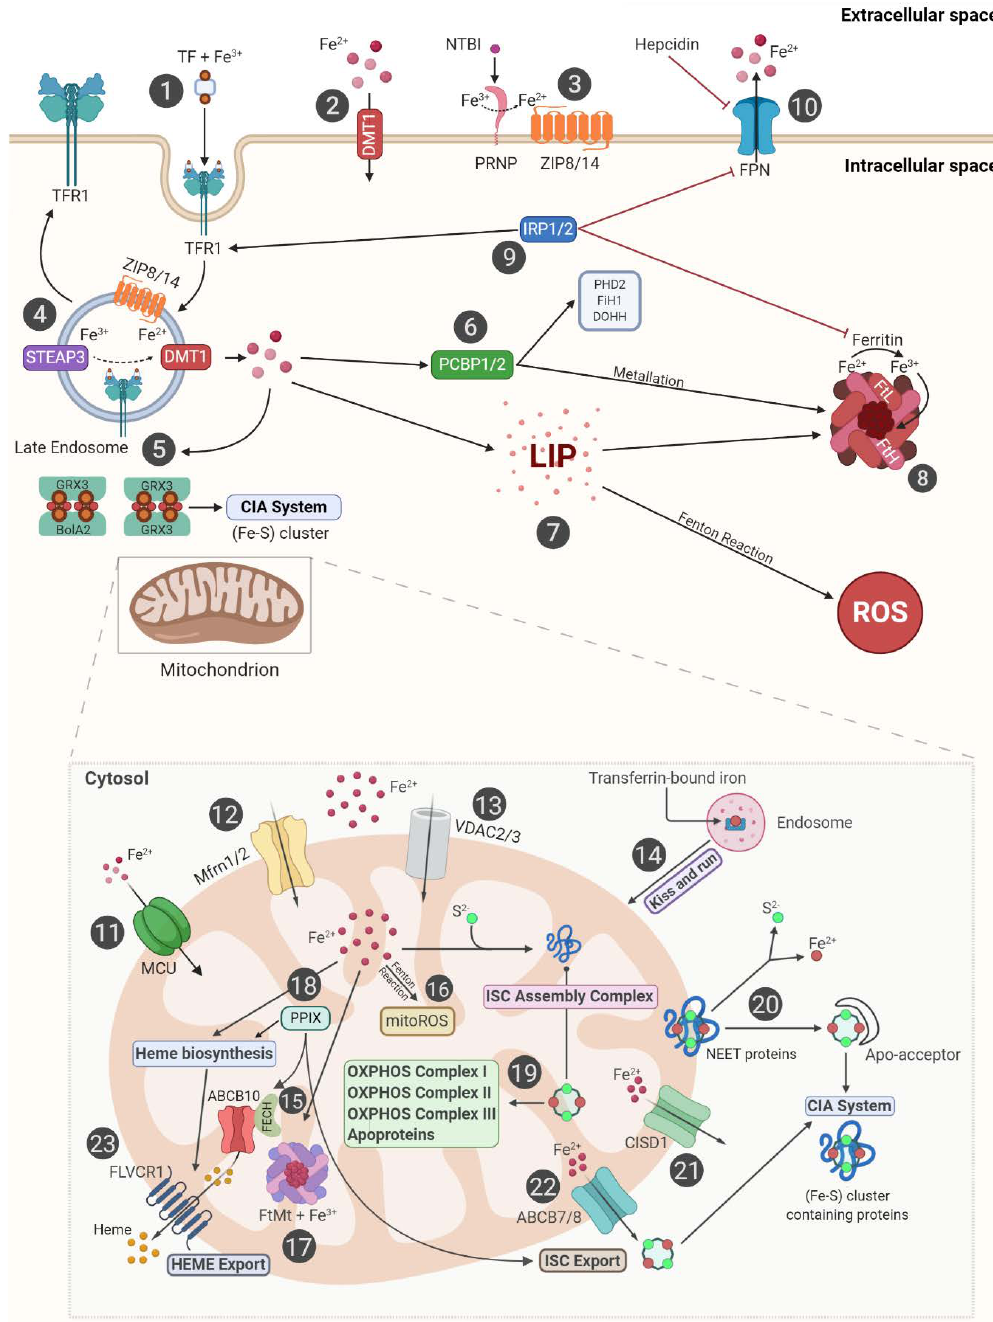
Figure 2. Iron crossroads from cytosol to mitochondria. Cytosolic iron metabolism: (1) TFR1 internalizes Fe 3 + -loaded TF through an endocytosis-mediated mechanism. (2) Fe 2 + uptake is carried out by the transmembrane permeable channel DMT1. (3) NTBI enters cytoplasm through the zinc transporter ZIP 8 / 14 upon its reduction in Fe 2 + mediated by PRNP. (4) Fe 3 + -loaded TF and NTBI are released in the endosome by TFR1 and ZIP8 / 14, respectively. STEAP3 converts Fe 3 + to Fe 2 + which, in turn, enters the cytoplasm via DMT1. After internalization, all these carriers are recycled to the cell surface. (5) GRX3 and BOLA2 constitute a heterotrimeric complex involved in the CIA system for (Fe–S) cluster formation. (6) PCBP1 / 2 iron chaperones bind iron and deliver it via direct protein–protein interaction with PHD2, FIH1, DOHH, and ferritin, in a process known as metallation. (7) LIP is a pool of free and redox-active iron which promotes ROS generation through a Fenton Reaction. (8) Ferritin is an iron-storage protein with ferroxidase activity, able to convert toxic Fe 2 + in non-toxic Fe 3 + , thus preventing a Fenton